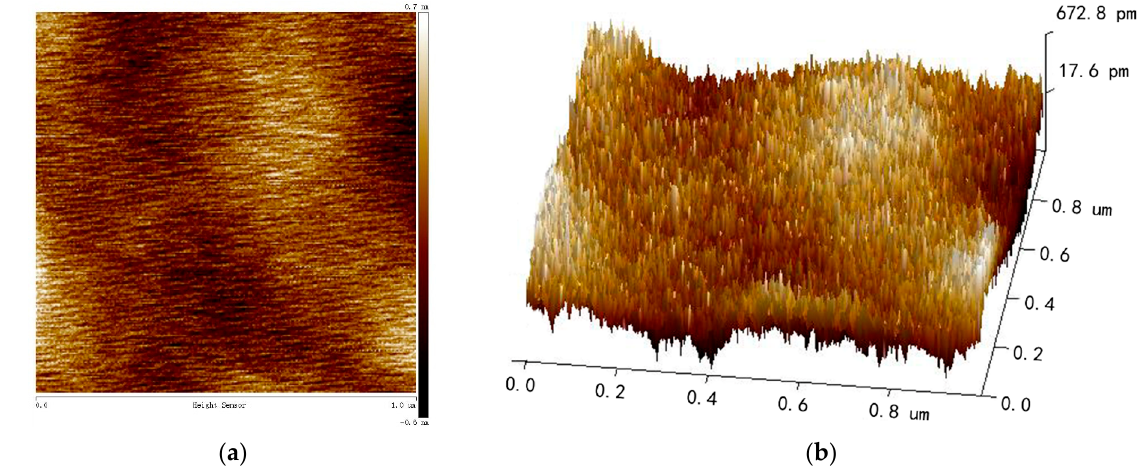
Figure 5. The roughness measurement results of ( a ) two- and ( b ) three-dimensional image for the sensing silicon structure.